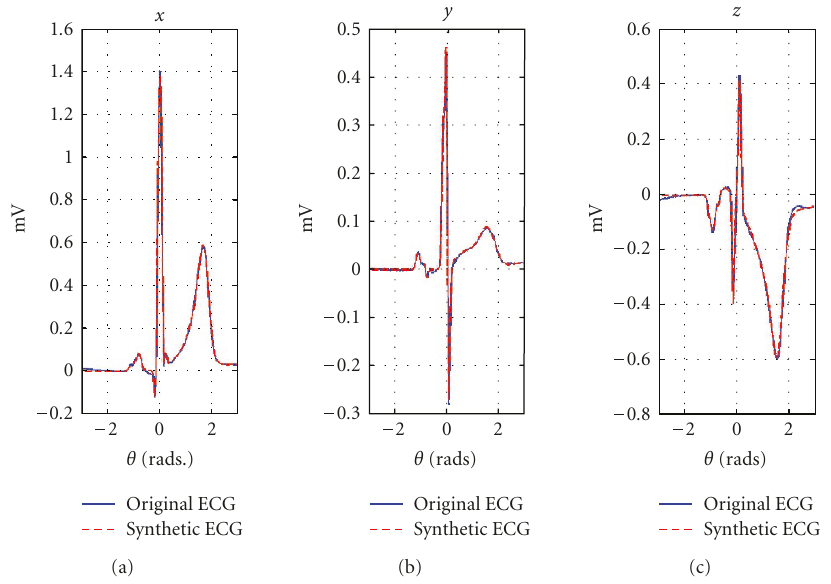
Figure 2: Synthetic ECG signals of the Frank lead electrodes.